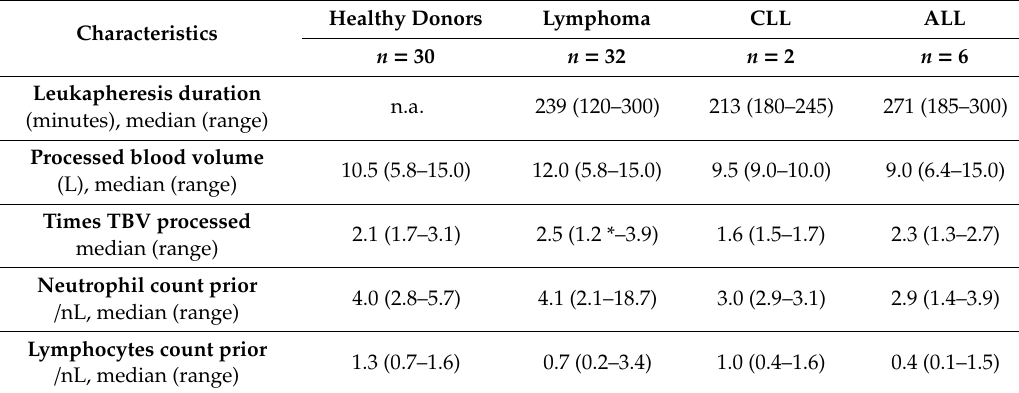
Table 3. Leukapheresis